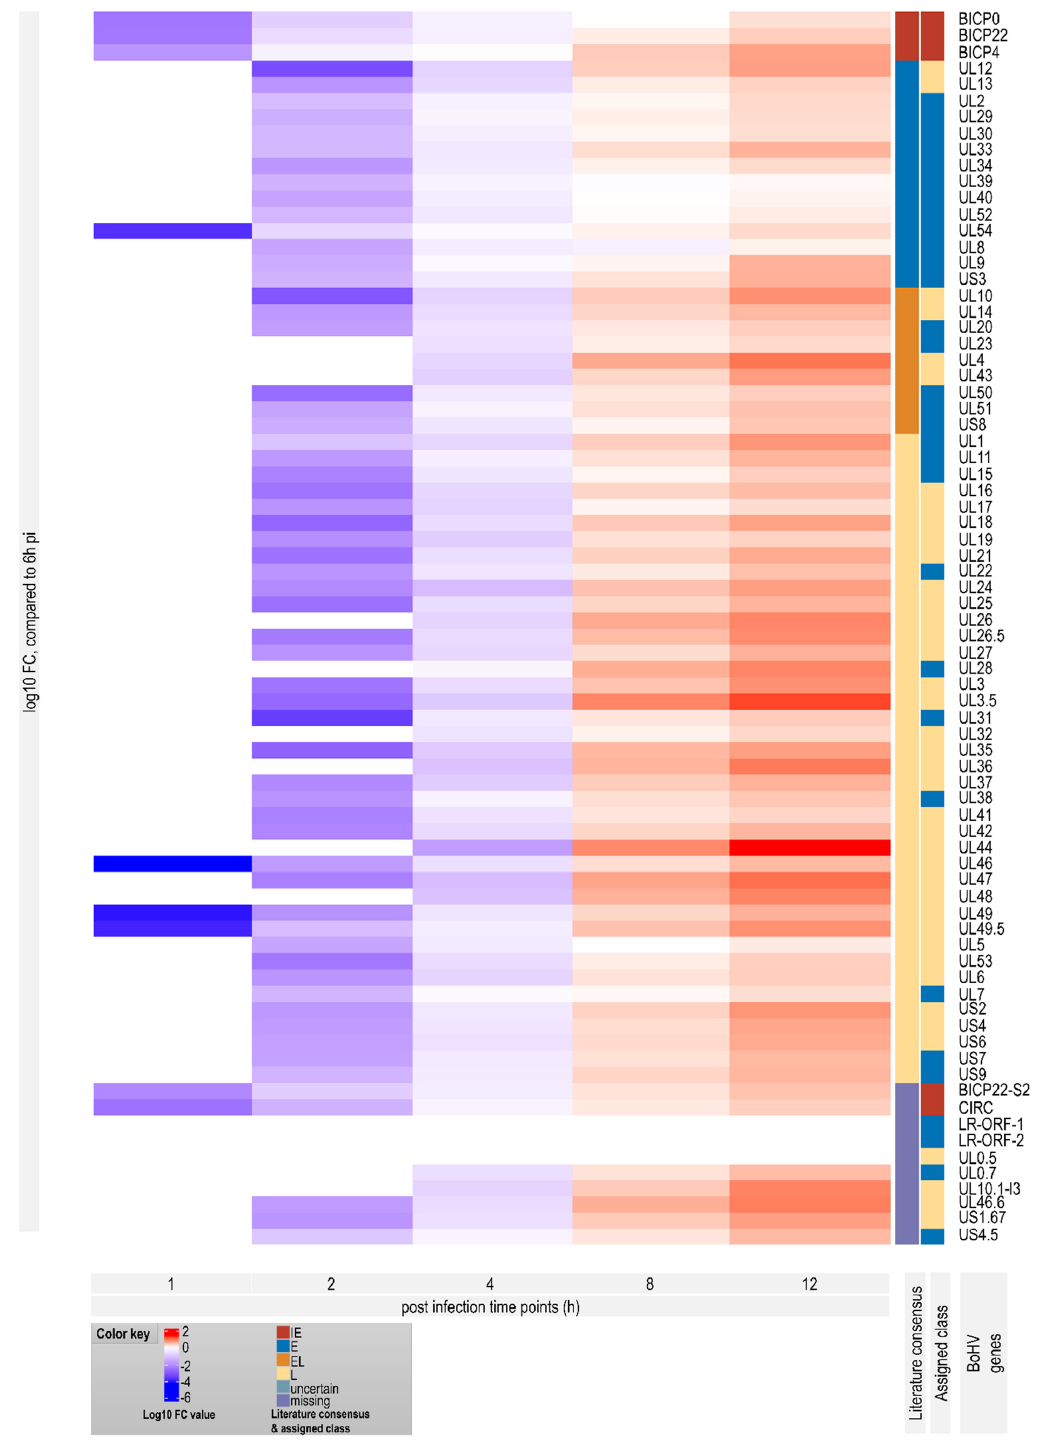
Figure 6. Heatmap of normalized gene expression of Bovine Herpesvirus during infection. Heatmap of Fold Change (log10FC), compared to 6 hpi of the viral genes, according to the abundance of their TSSs. The colors show the mean log10 fold change values of the simple ratio normalized viral read counts compared to 6 hpi samples. For this reason, the 6 hpi sample is omitted. The two annotation columns on the right show the kinetic categories of each gene: the inner column shows the literature consensus (the kinetic category associated most of the time with the gene), while the outer column shows kinetic category according to our